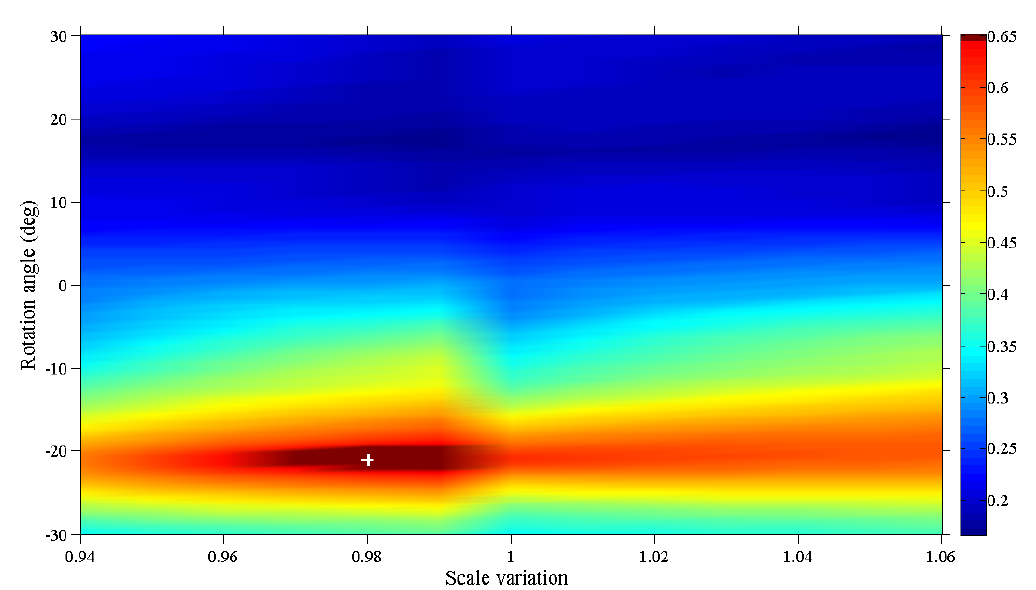
Figure 9. Map of the correlation coefficient maxima obtained via FFT of image pairs that are rotated and scaled by the quantities reported on the plot axes. The white cross identifies the rotation angle and scale variation, which provides the maximum correlation function value.